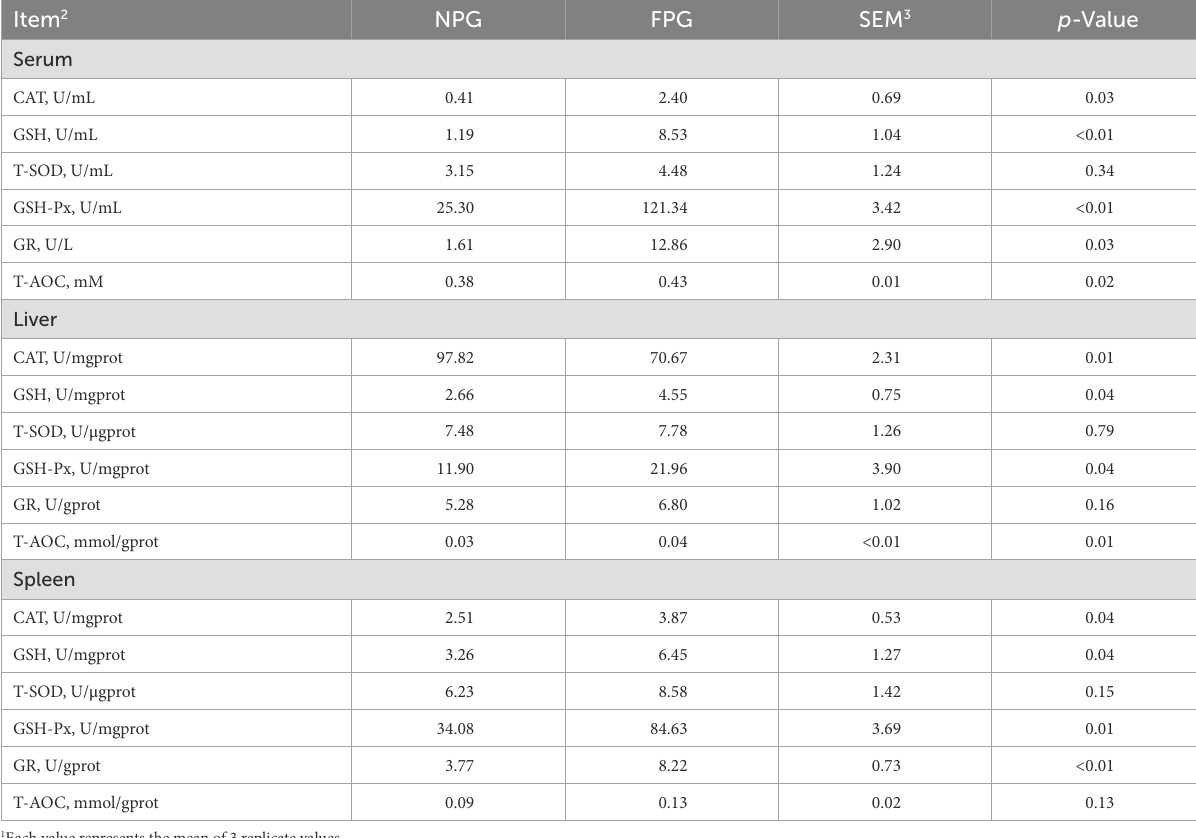
TABLE 7 Effect of fermented feed of Pennisetum giganteum on antioxidant status in the serum, liver and spleen of Boer goats in thermal stress 1